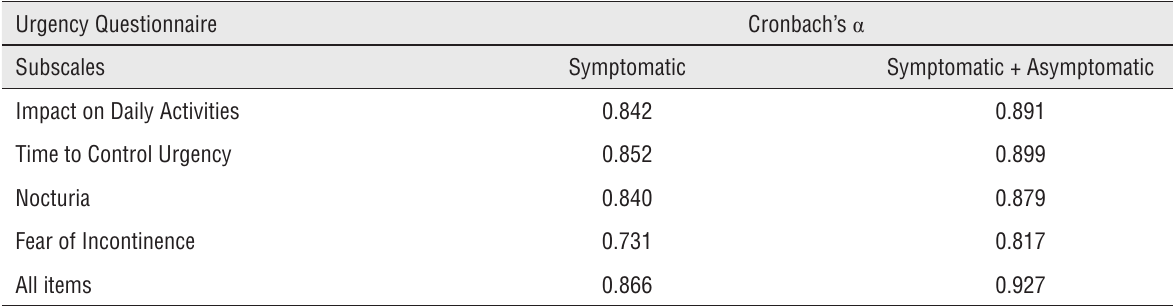
Analyses used paired t-tests comparing responses at visit 1 and visit 2. Table 6 - Internal consistency of the Urgency Questionnaire